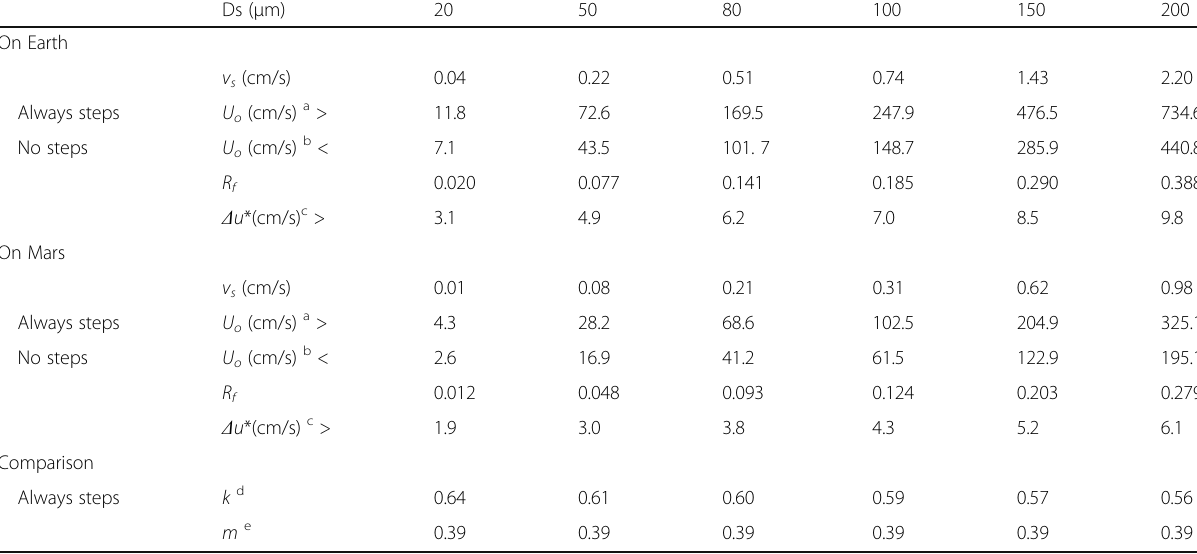
Table 1 Calculated formative conditions for submarine cyclic steps on Earth and Mars Ds ( μ